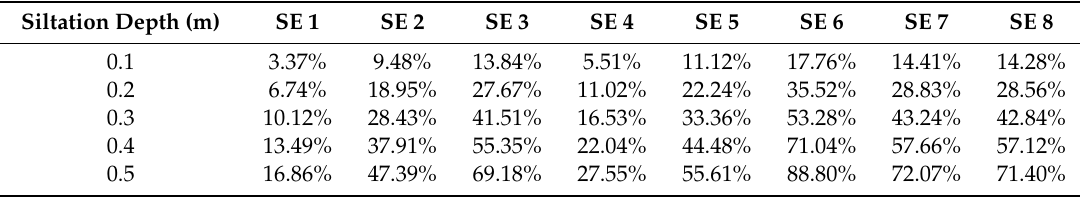
Table 8. Reduction ratio of e-flow requirement for di ff erent river segments (SE) under the low hydrological connectivity